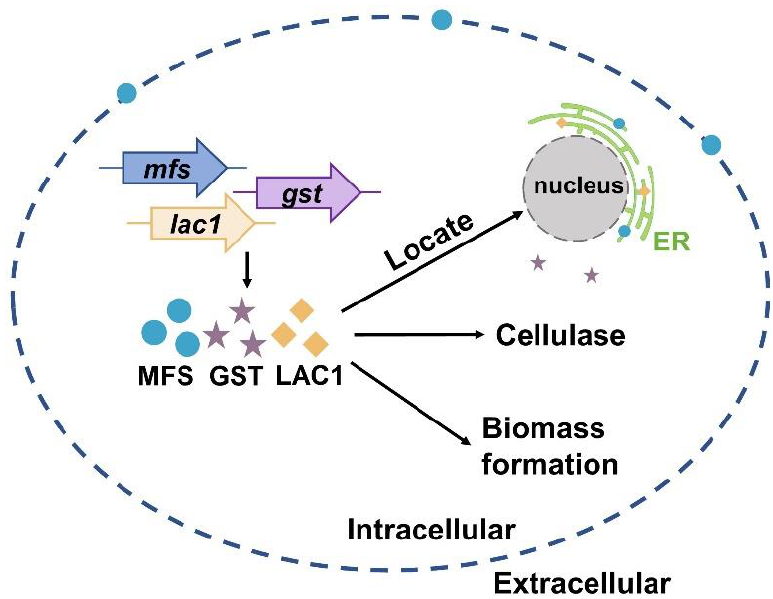
Figure 6. A scheme of the function and cellular distribution of three intracellular sugar transporters in T. reesei when cultured in lactose.